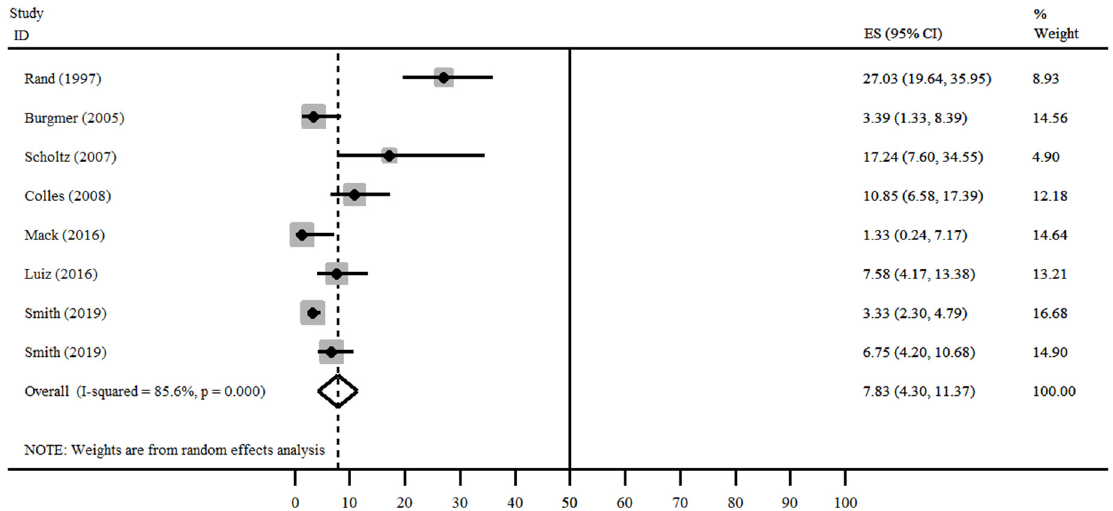
Figure 4. Total prevalence of disorders in the postoperative period [13–26].